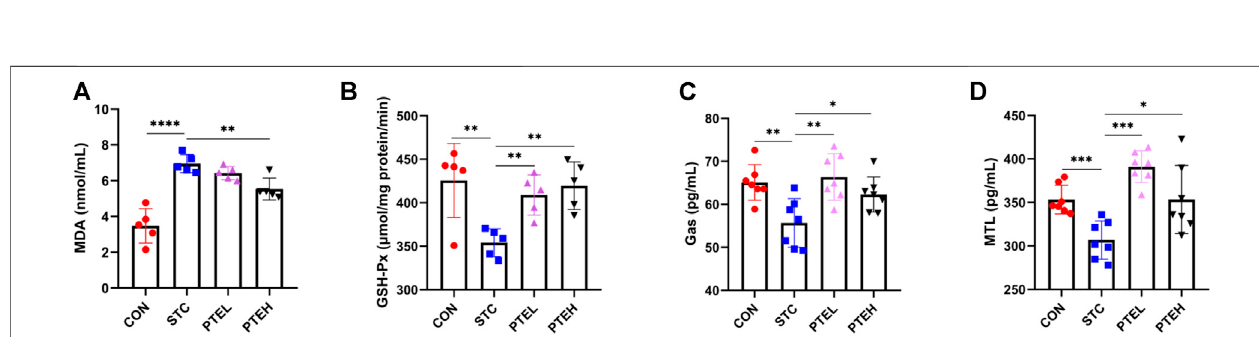
Frontiers in Pharmacology |